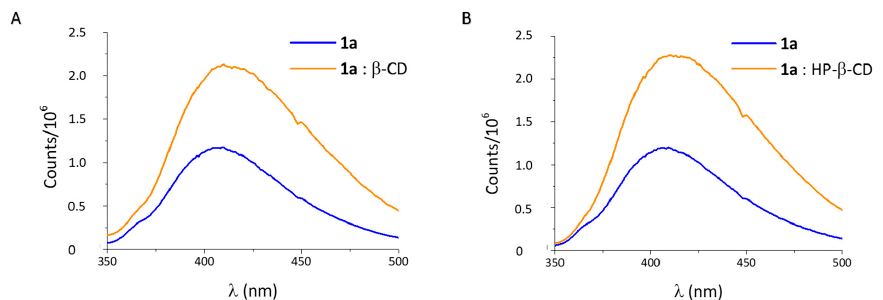
Figure 5. Job’s plot for 1a : β -CD and 1a :HP- β -CD complexes, for ( A ) H-5 proton of β -CD and ( B ) acetyl protons of 1a, respectively.